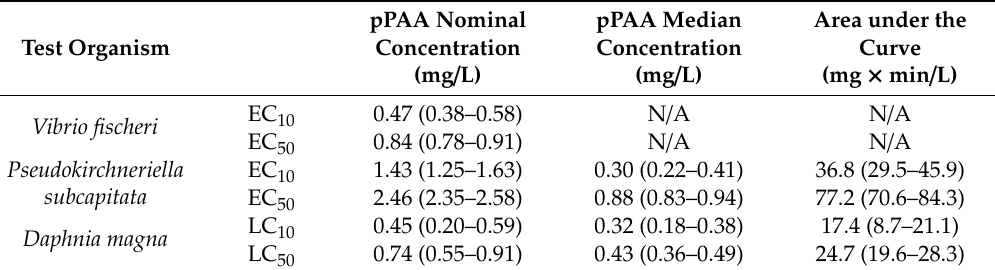
Table 2. E ff ect concentration (EC 10 and EC 50 ) on V. fischeri at 30 min contact time of pure PAA (pPAA) and algae at 72 h of contact time of pPAA and lethal concentration (LC 10 and LC 50 ) on Daphnia magna at 48 h of contact time of pPAA based on PAA’s nominal concentration (95% confidential interval in parenthesis). Number of data available for calculations: 5 for each indicator.